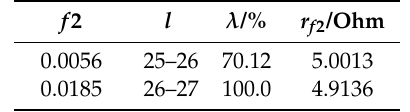
Table 13. Optimal solutions of f 2 when fault occurred at each branch in set 2 for Case